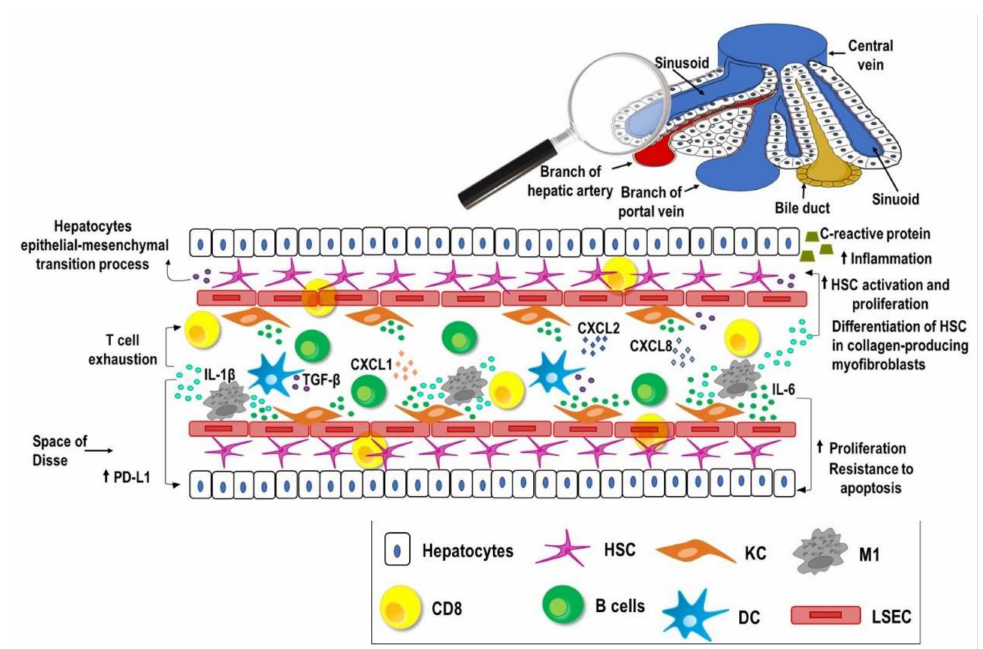
Figure 1. The liver as an immunological organ. Because of its distinctive structure and specific blood supply route, the liver preserves a unique immune microenvironment. The liver sinusoidal endothelial cells (LSECs) form the fenestrated wall of the liver sinusoid and control the trafficking of molecules and cells from the liver parenchyma to the blood. At the sinusoids, circulating lymphocytes interact with antigens presented by endothelial cells, Kupffer cells (KCs), and liver resident dendritic cells (DCs), and, through fenestrations, they can access to the Disse space to get in touch with hepatocytes and hepatic stellate cells (HSCs). During liver injury or infection, a local inflammatory response is triggered as a result of the release of inflammatory cytokines (IL-6, IL-1 β , and TGF- β ) and chemokines (CXCL1, CXCL2, and CXCL8), leading to tissue damage and HCC development. Specifically, KCs and M1 macrophages produce IL-6 and TGF- β , which induce hepatocytes proliferation and resistance to apoptosis, and trigger the hepatocytes epithelial–mesenchymal transition (EMT) process and the differentiation of HSCs in collagen-producing myofibroblasts that promote fibrosis. Hepatocytes are mainly responsible for the production of the C-reactive protein supporting inflammation. M1 macrophages also release IL-1 β , which enhances PD-L1 expression on hepatocytes resulting in T cells exhaustion and tumor